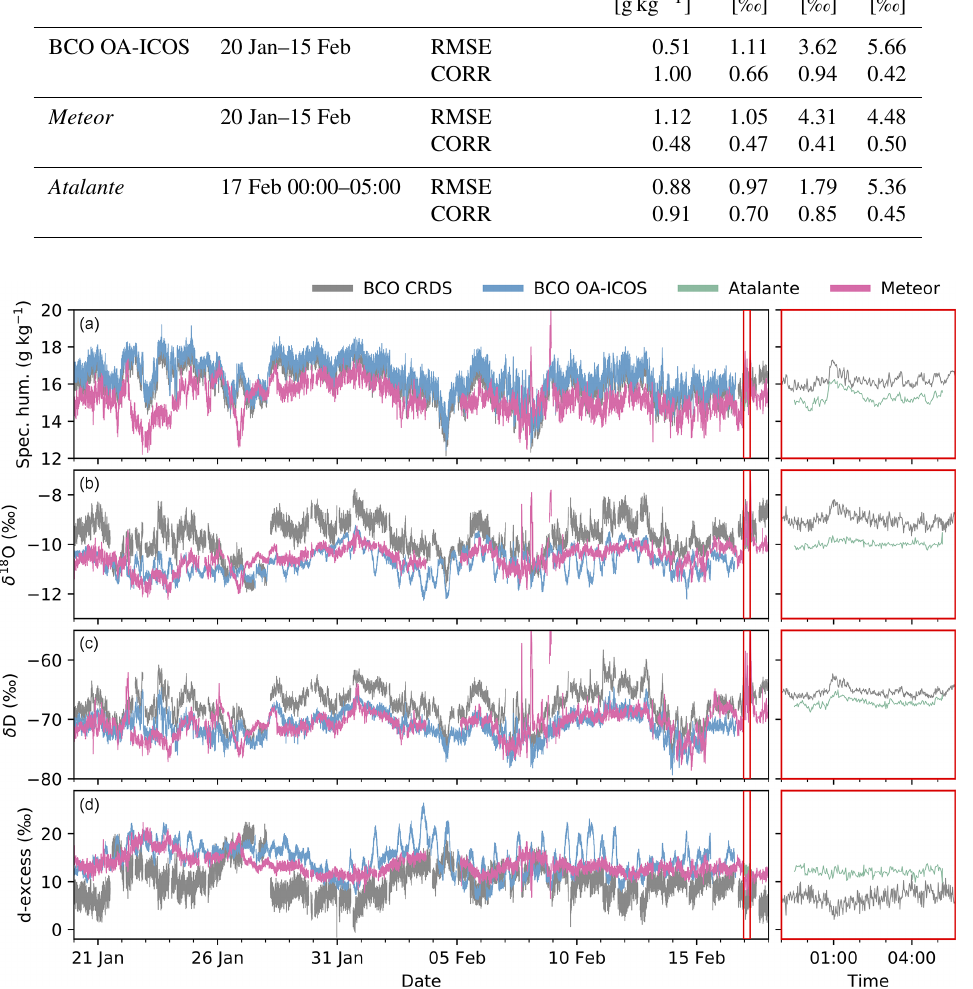
Figure 12. Time series of (a) water vapor concentration, (b) δ 18 O, (c) δ D, and (d) d from the BCO CRDS analyzer (gray), the BCO OA- ICOS analyzer (blue), and the Meteor (magenta) for the period 20 January–17 February 2020 (DOY 20-48). The Meteor trace is shifted by 9h. Rightmost panels show an enlarged view of the BCO CRDS system and the Atalante (teal) for the period 23:30 16 February–05:10 17 February UTC (DOY 47-48), when the Atalante was 2–6km northeast of the BCO. The Atalante trace is shifted by 10min. (Note that the time series shown here are not smoothed as they are for the comparisons described in Table